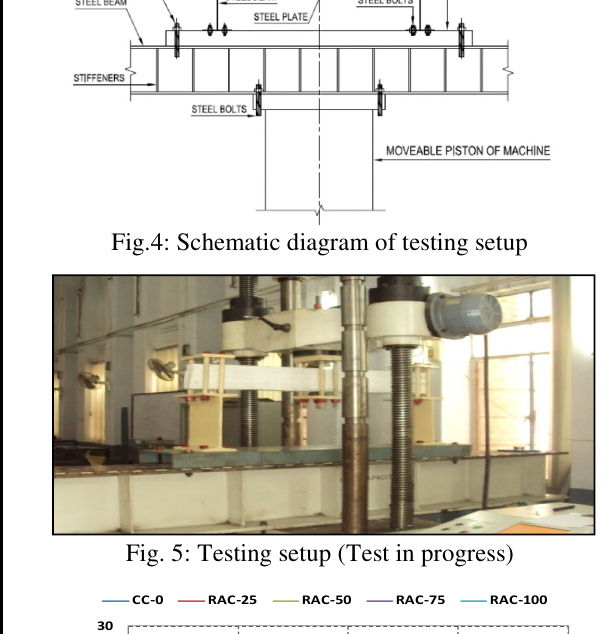
Fig. 5: Testing setup (Test in progress)